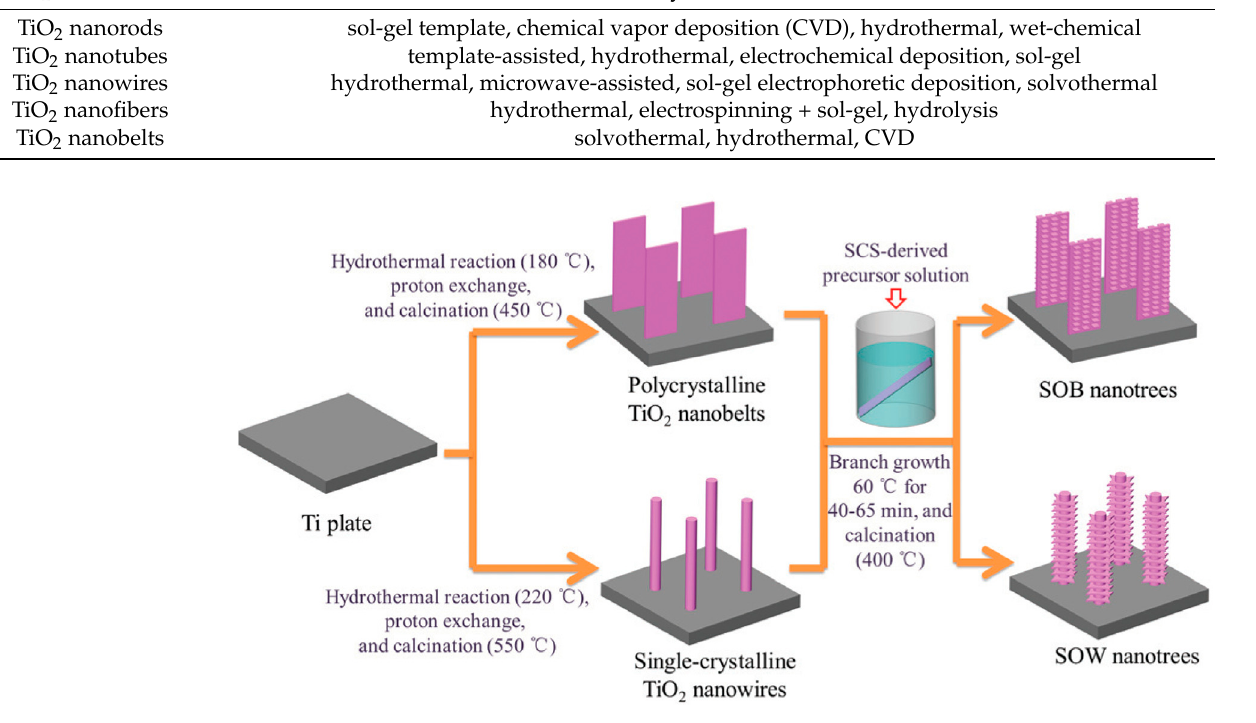
Figure 4. Synthesis steps of TiO 2 nanotrees that can be divided into sheeton-belt (SOB) and sheet-on-wire (SOW) [51]. Reproduced with permission from the Royal Society of Chemistry, 2022.